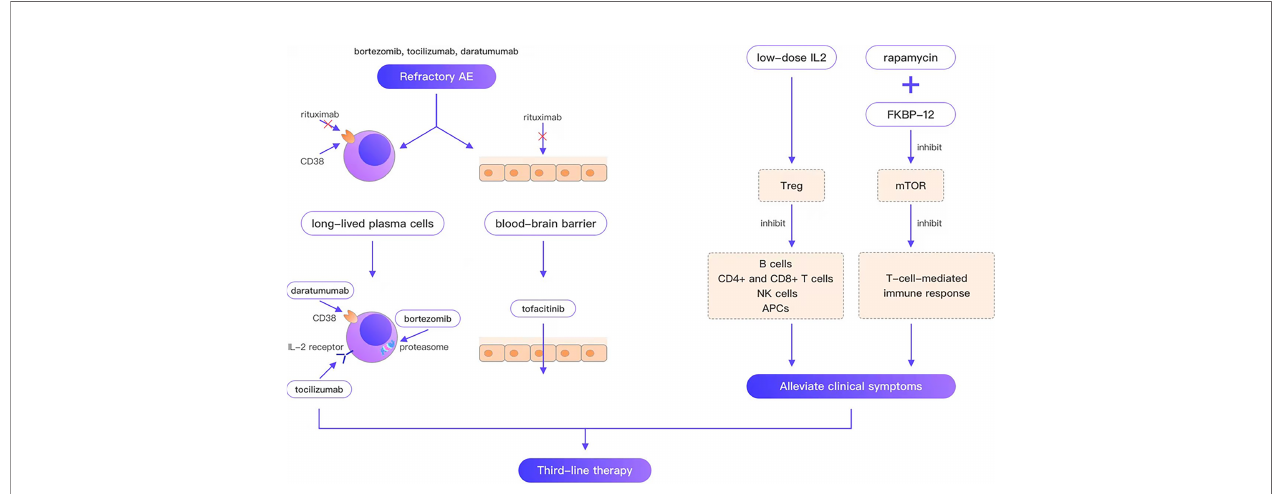
FIGURE 1 | Bortezomib, tocilizumab, and daratumumab overcome the weakness that rituximab cannot target plasma cells; tofacitinib overcomes the weakness that rituximab cannot cross the blood-brain barrier; low-dose IL2, rapamycin can alleviate the clinical